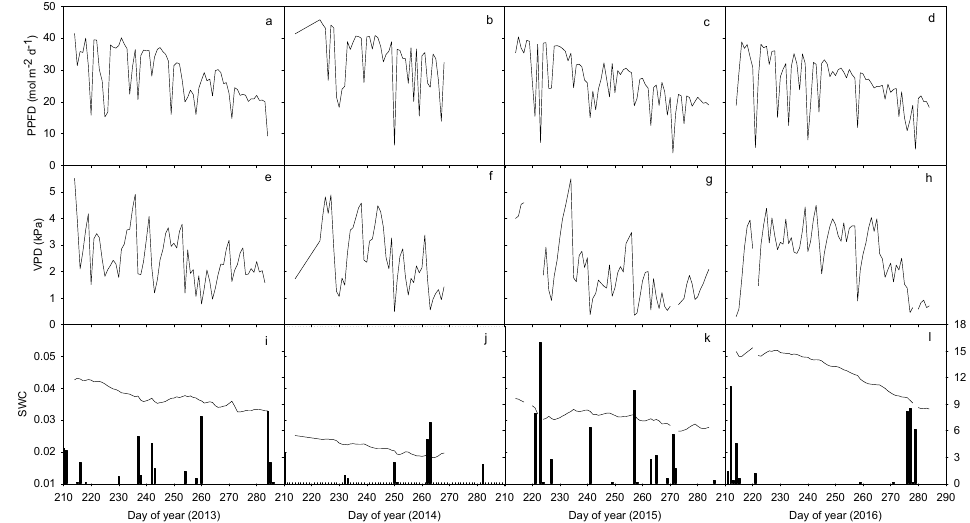
Figure 1. Daily photosynthetic photon flux density (PPFD, a – d ), vapor pressure deficit (VPD, e – h ), rainfall and volumetric soil water content (SWC, i – l ) during the second half of the growing season (August 1 to early October) between 2013 and 2016. PPFD and VPD were computed every day during daytime when PPFD ≥ 40 μ mol m − 2 s − 1 while rainfall and SWC were computed every whole day.